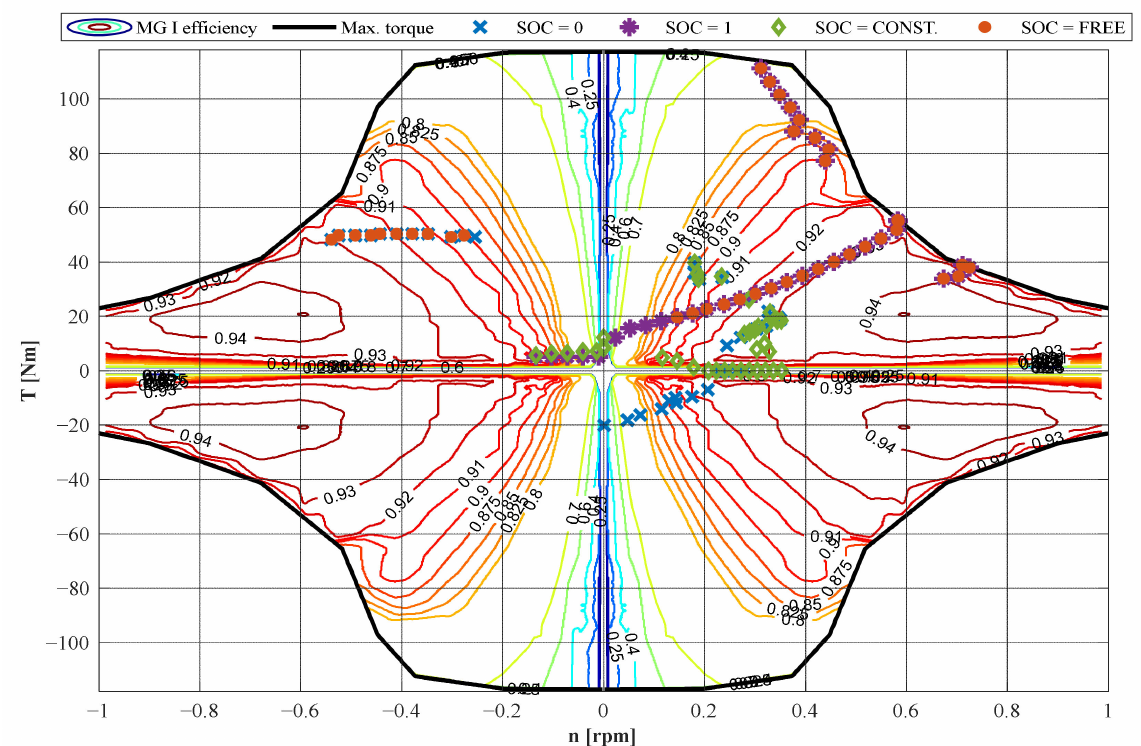
Figure 8. MG I optimal functioning points in power-split